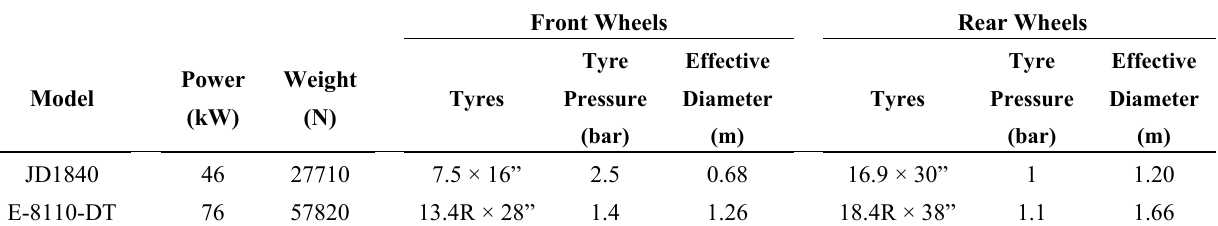
Table 2. Characteristics of tractor